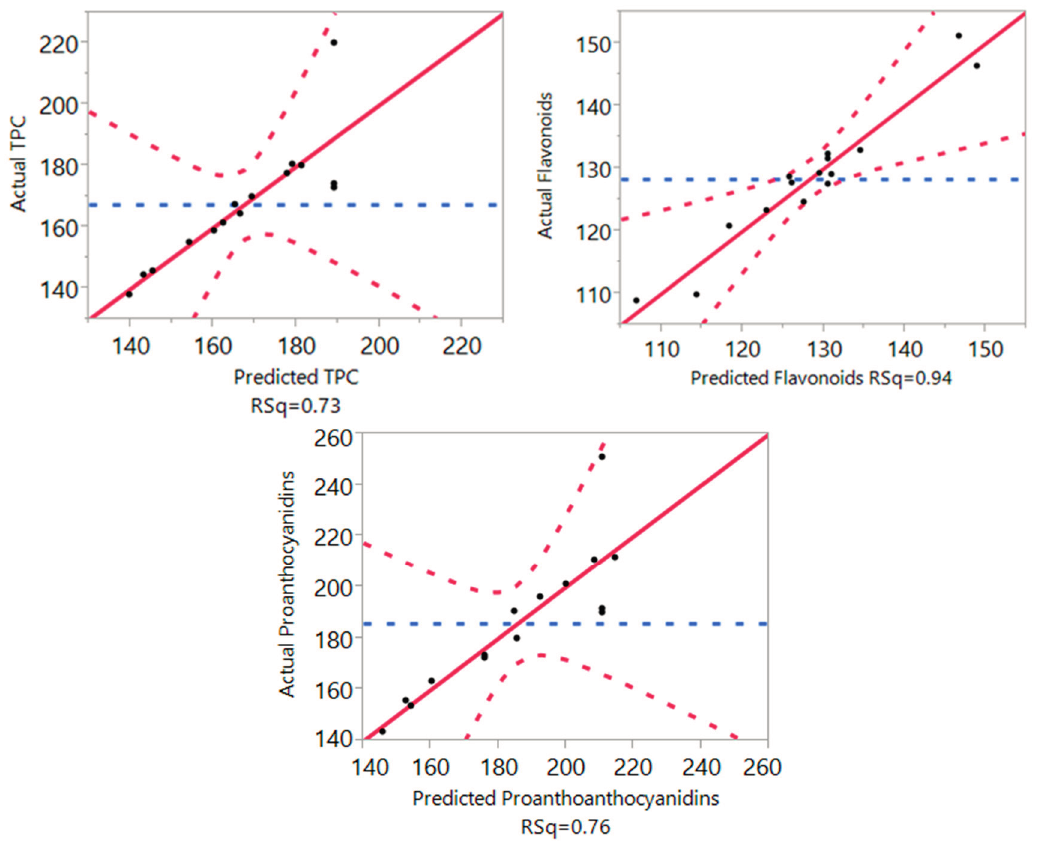
Figure 2. Correlation between the predicted and the experimental values for TPC, flavonoids, and